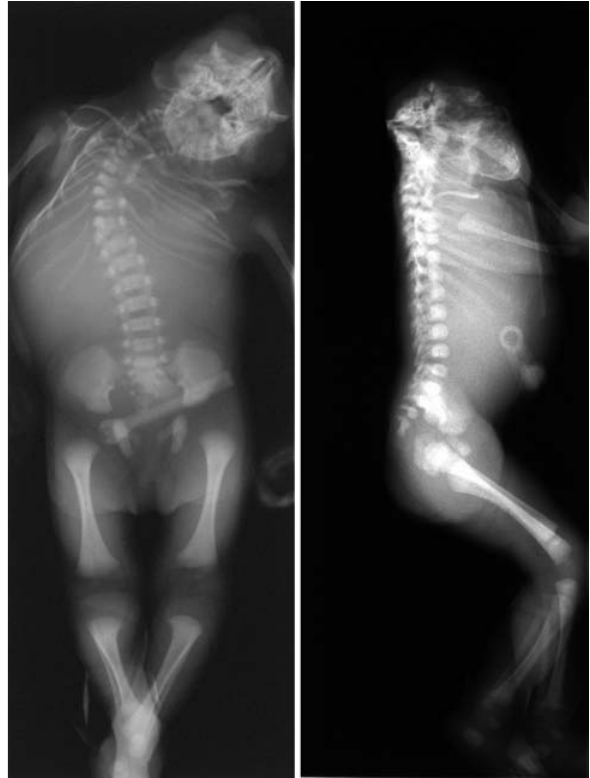
Figure1 -Partialbabygramofthefoetus.Noteabsenceofthecalvariaand vertebral